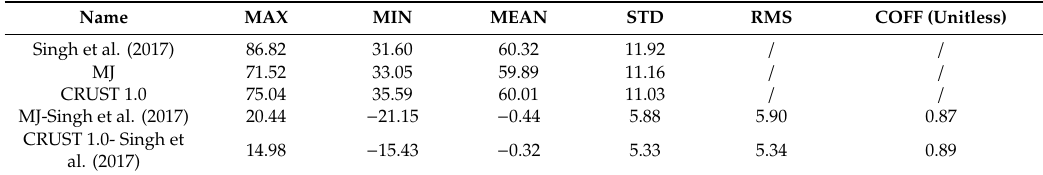
Figure 7. ( a ) Di ff erences of crustal thickness between CRUST1.0 and Singh et al. (2017) [59]; ( b ) di ff erences of crustal thickness between MJ and Singh et al. (2017) [59]. Table 2. Statistics of crustal thickness for the three models and their di ff erences (unit: